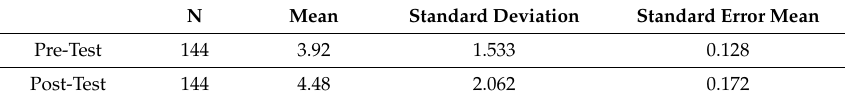
Table 5. Descriptive statistics for the pre-test and post-test values in First Garde.